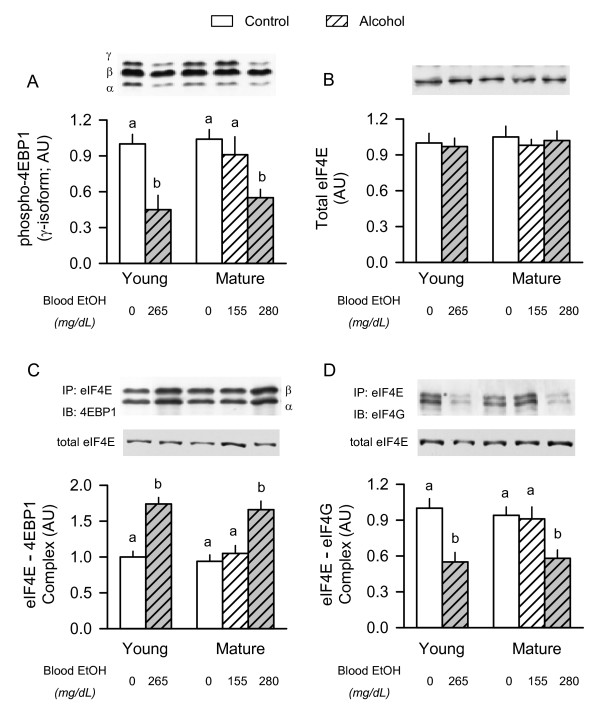
Effect of acute alcohol intoxication on 4E-BP1 phosphorylation and the formation of the active eIF4F complex in skeletal muscle from young and mature rats. Groups are the same as described in Figure 1. Gastrocnemius was collected 2.5 h after administration of alcohol or saline (control). Insert above each graph: representative Western blots. Panels A and B: densitometric analysis of immunoblots of γ-phosphorylated 4E-BP1 and total eIF4E in muscle homogenate, respectively, Panels C and D: eIF4E was immunoprecipitated (IP) and the amount of 4EBP1 and eIF4G bound to eIF4E was assessed by immunoblotting (IB). There was no age- or alcohol-induced change in total eIF4E in the immunoprecipitate (data not shown). In panel C, the α- and β-isoforms of 4E-BP1 are indicated. Values (means ± SEM) are expressed relative to the young saline-treated control group. Sample size was 10, 10, 6, 7, 9, and 9 for the six groups, respectively. Values with different letters are significantly different from each other, P < 0.05. Values which share a common letter are not statistically different.